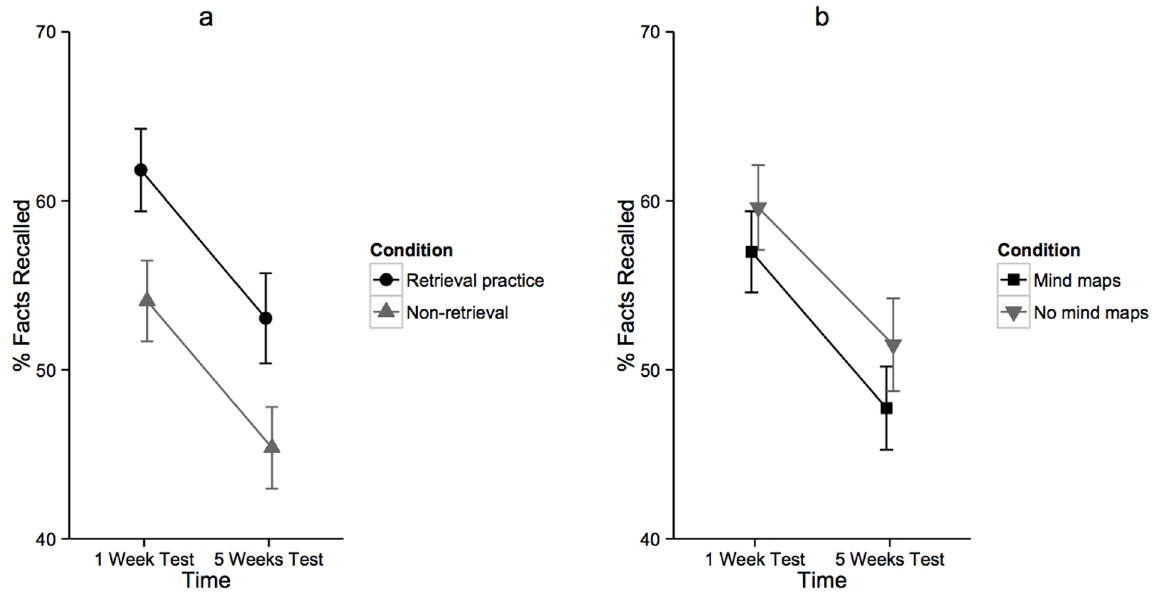
Figure 2. Percentage of facts recalled at the one- and five-week tests in Experiment 2 for (a) the retrieval practice and non-retrieval conditions and (b) the mind maps and no mind maps conditions. Error bars represent + / 2 1 standard error.